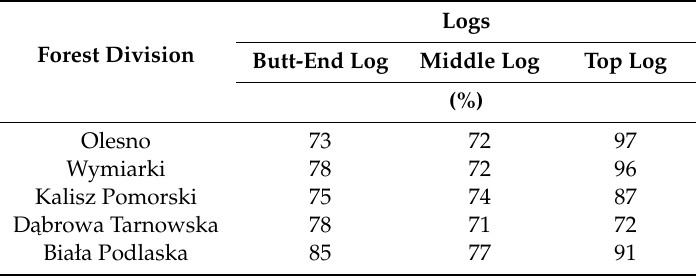
Table 15. The percentage of knots as a factor a ff ecting the quality class of sawn timber in the longitudinal section of long logs for the various forest